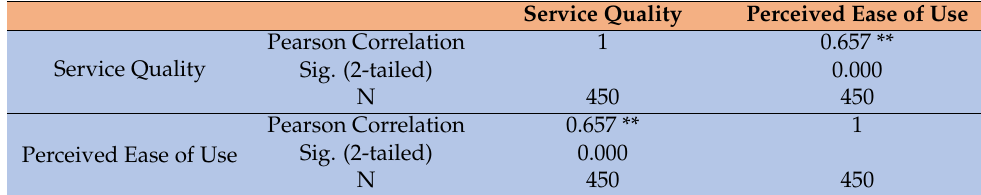
Table 10. Results of the correlation analysis for hypothesis 5 (H5).